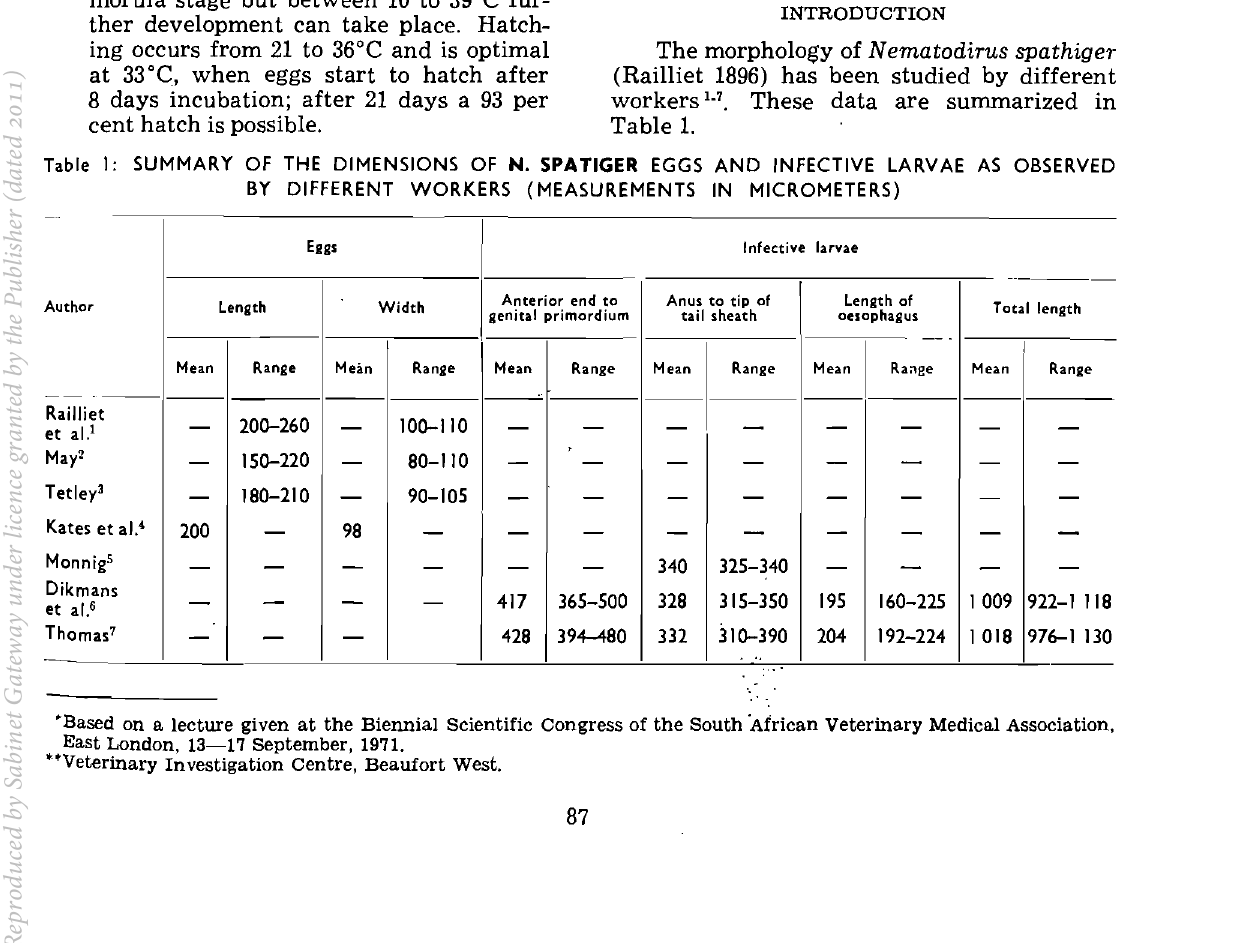
Table 1: SUMMARY OF THE DIMENSIONS OF N. SPATIGER EGGS AND INFECTIVE LARVAE AS OBSERVED BY DIFFERENT WORKERS (MEASUREMENTS IN